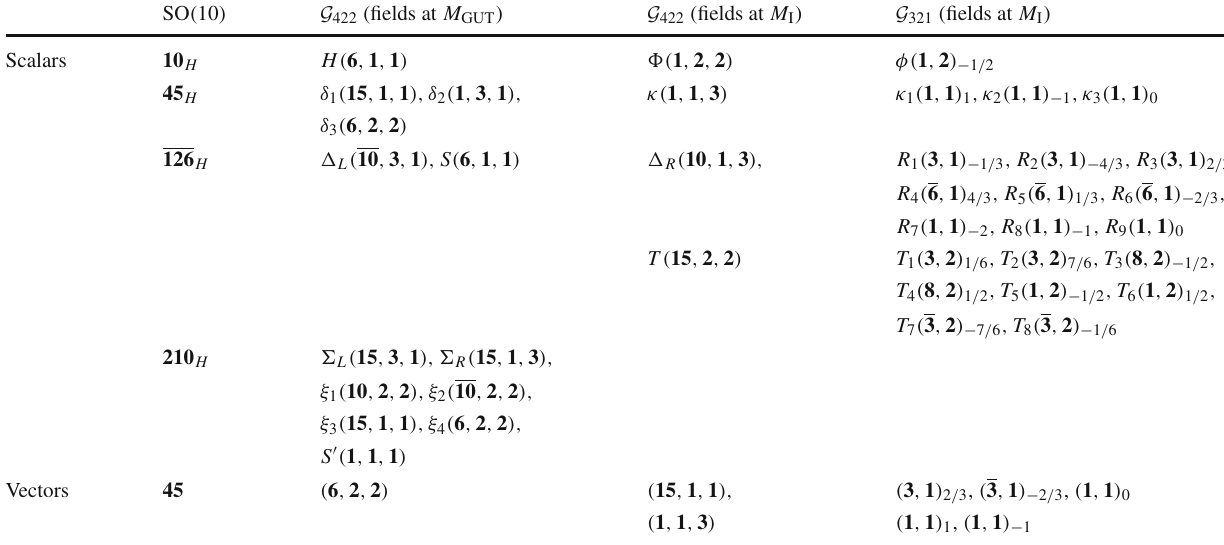
Table 4 Scalar and vector fields that have masses around M GUT and M I in the G 422 model SO ( 10